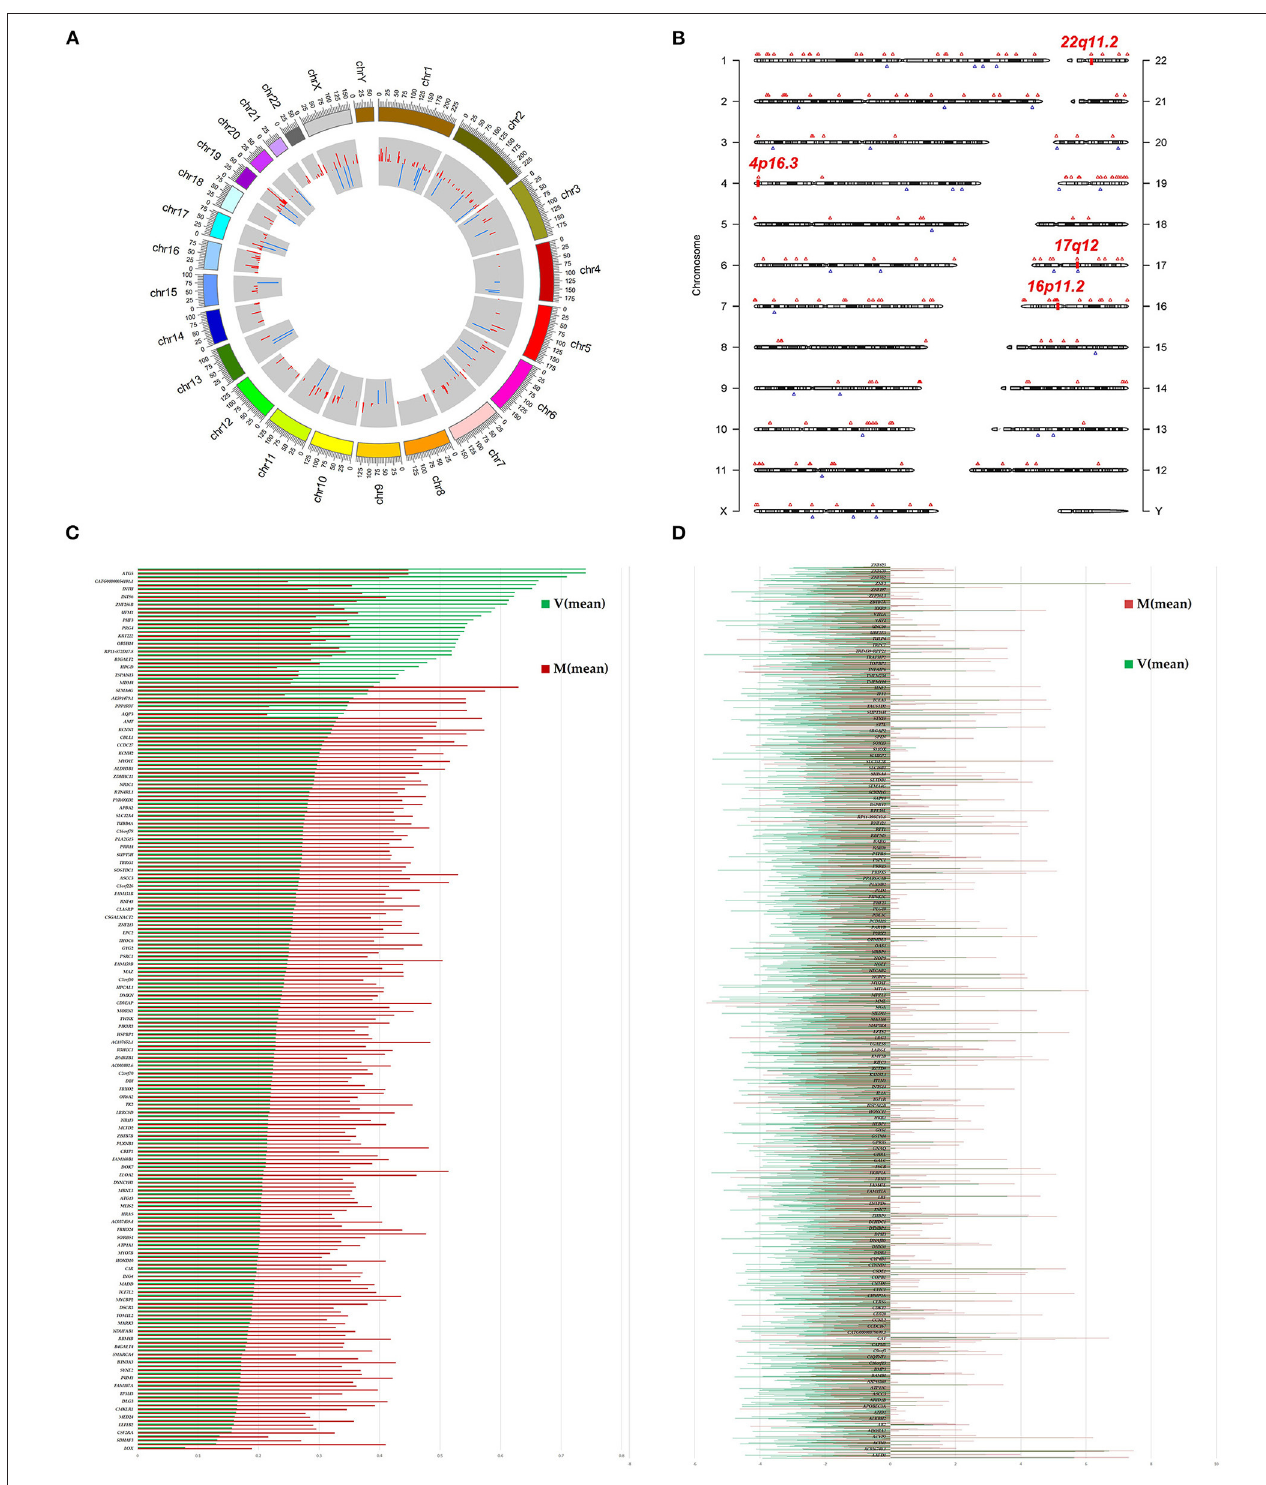
FIGURE 2 | Landscape of N6 -methyladenosine (m 6 A)-modified transcript in ureter tissue samples from patients with megaureter (M) or vesicoureteral reflux (VUR, V). (A) The m 6 A peaks’ density distribution along the chromosomes. The first (red circle) and second (blue circle) tracks indicate the frequency distribution of the hyper- and hypomethylated peaks, respectively. chr, chromosome. (B) Chromosomal distribution patterns of the hypermethylated (red) and hypomethylated (blue) m6A peaks within mRNAs. (C) Differentially methylated mRNAs based on log2(FC). (D) Differentially expressed mRNAs based on log2(FC).